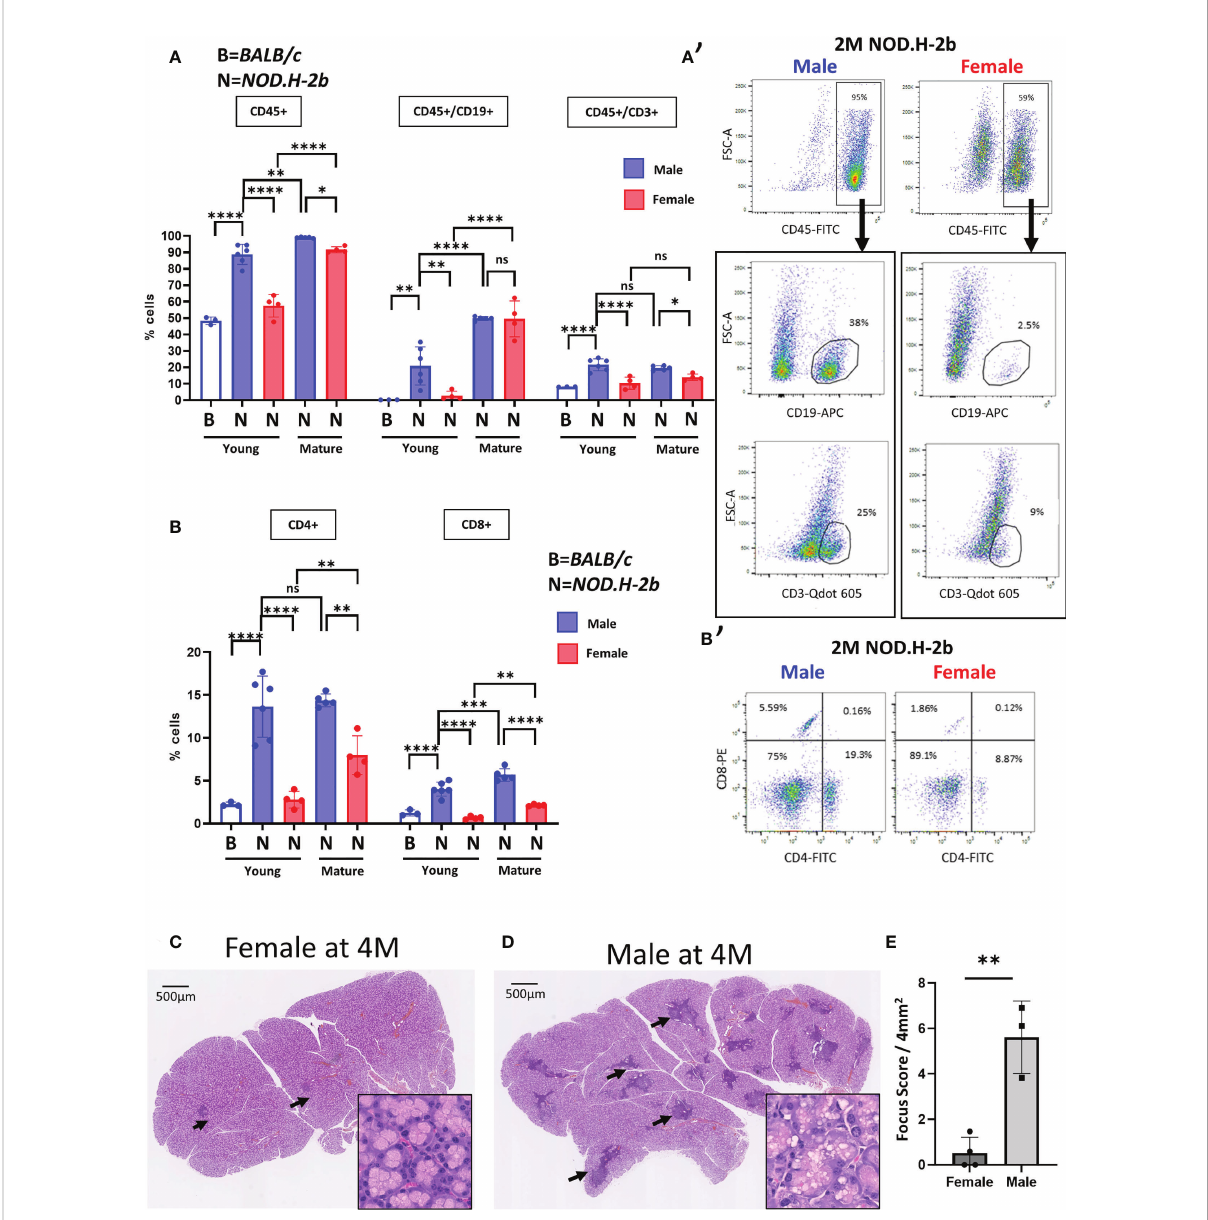
FIGURE 1 Increase of B and T cells proportion in Male NOD.H-2b mice with age. CD45 + immune cells were analyzed by fl ow cytometry of LGs from BALB/c (B) and NOD.H.2b (N) mice. (A, A ’ ) Comparison of B cells (CD19 + ) and T cells (CD3 + ) between LGs of NOD.H-2b male and female have been performed at 2 and 6M within immune population (CD45 + ) 2M old BALB/c have been used as control (empty bar). A representative plot at 2M is shown for male and female (A ’ ) . (B) Histogram showing proportion of CD4 + and CD8 + cells. A representative plot at 2M is shown for male and female (B ’ ) . (A, B) Values are shown as mean ± SD. Statistical signi fi cance assessed with ANOVA test. Adjusted P-value signi fi cance: *: p <0.05; **: p <0.01; ***: p <0.001; ****: p <0.0001; ns: non-signi fi cant. (C, D) H&E staining of LGs from NOD.H-2b female (C) and male (D) showed immune in fi ltrates (black arrows). (E) Histogram representing focus score of LGs between male and female at 4 months Plot shows mean ± SD. Statistical signi fi cance assessed with an unpaired t-test (**: